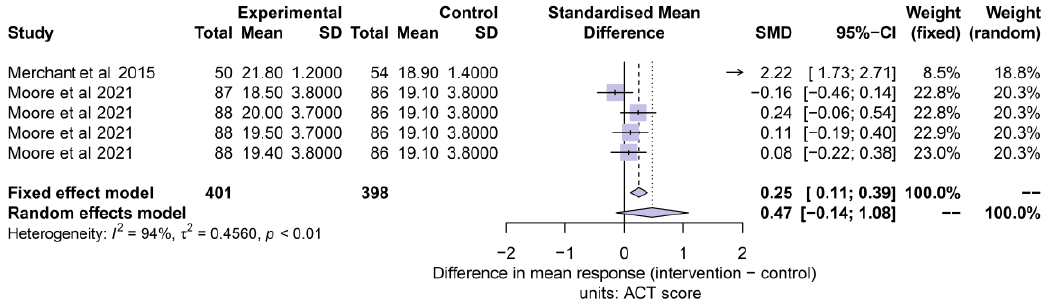
Figure 7. Asthma control test (ACT) outcomes. References: 23, 51.